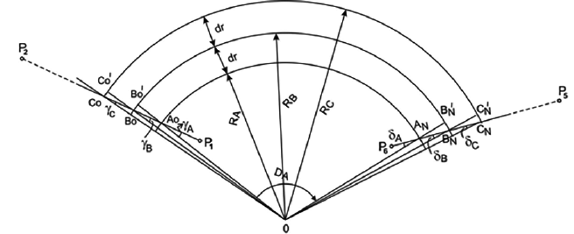
Figure 4. The intersection points (A O, B O , C O , ..., K O ; A N , B N , C N , ..., K N ) of the starting and finishing points with auditorium side walls (P 1 P 2 , P 6 P 5 ) until from second row to the end row (i. row)